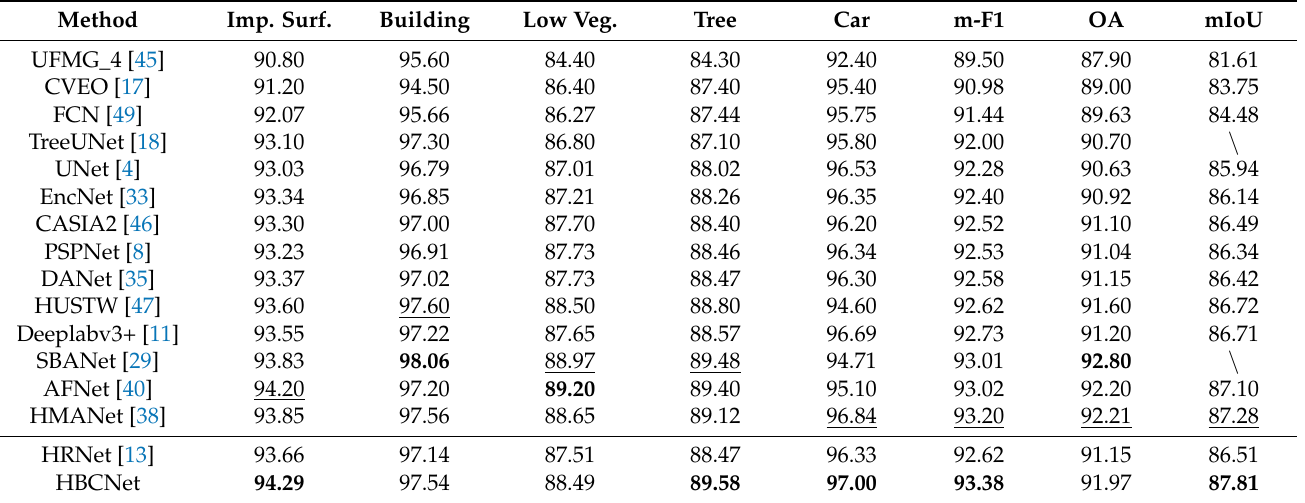
Table 3. Experimental results (%) for the Potsdam dataset. The values in bold are the best and the values underlined are the second